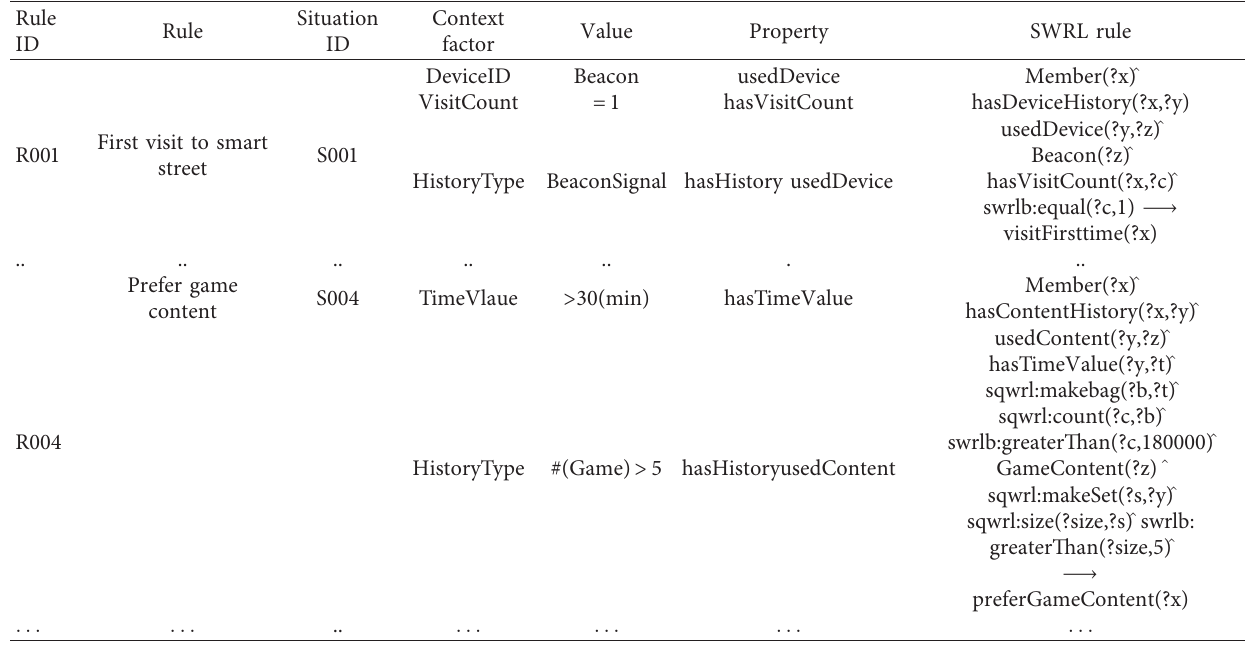
Table 4: Situation and reasoning